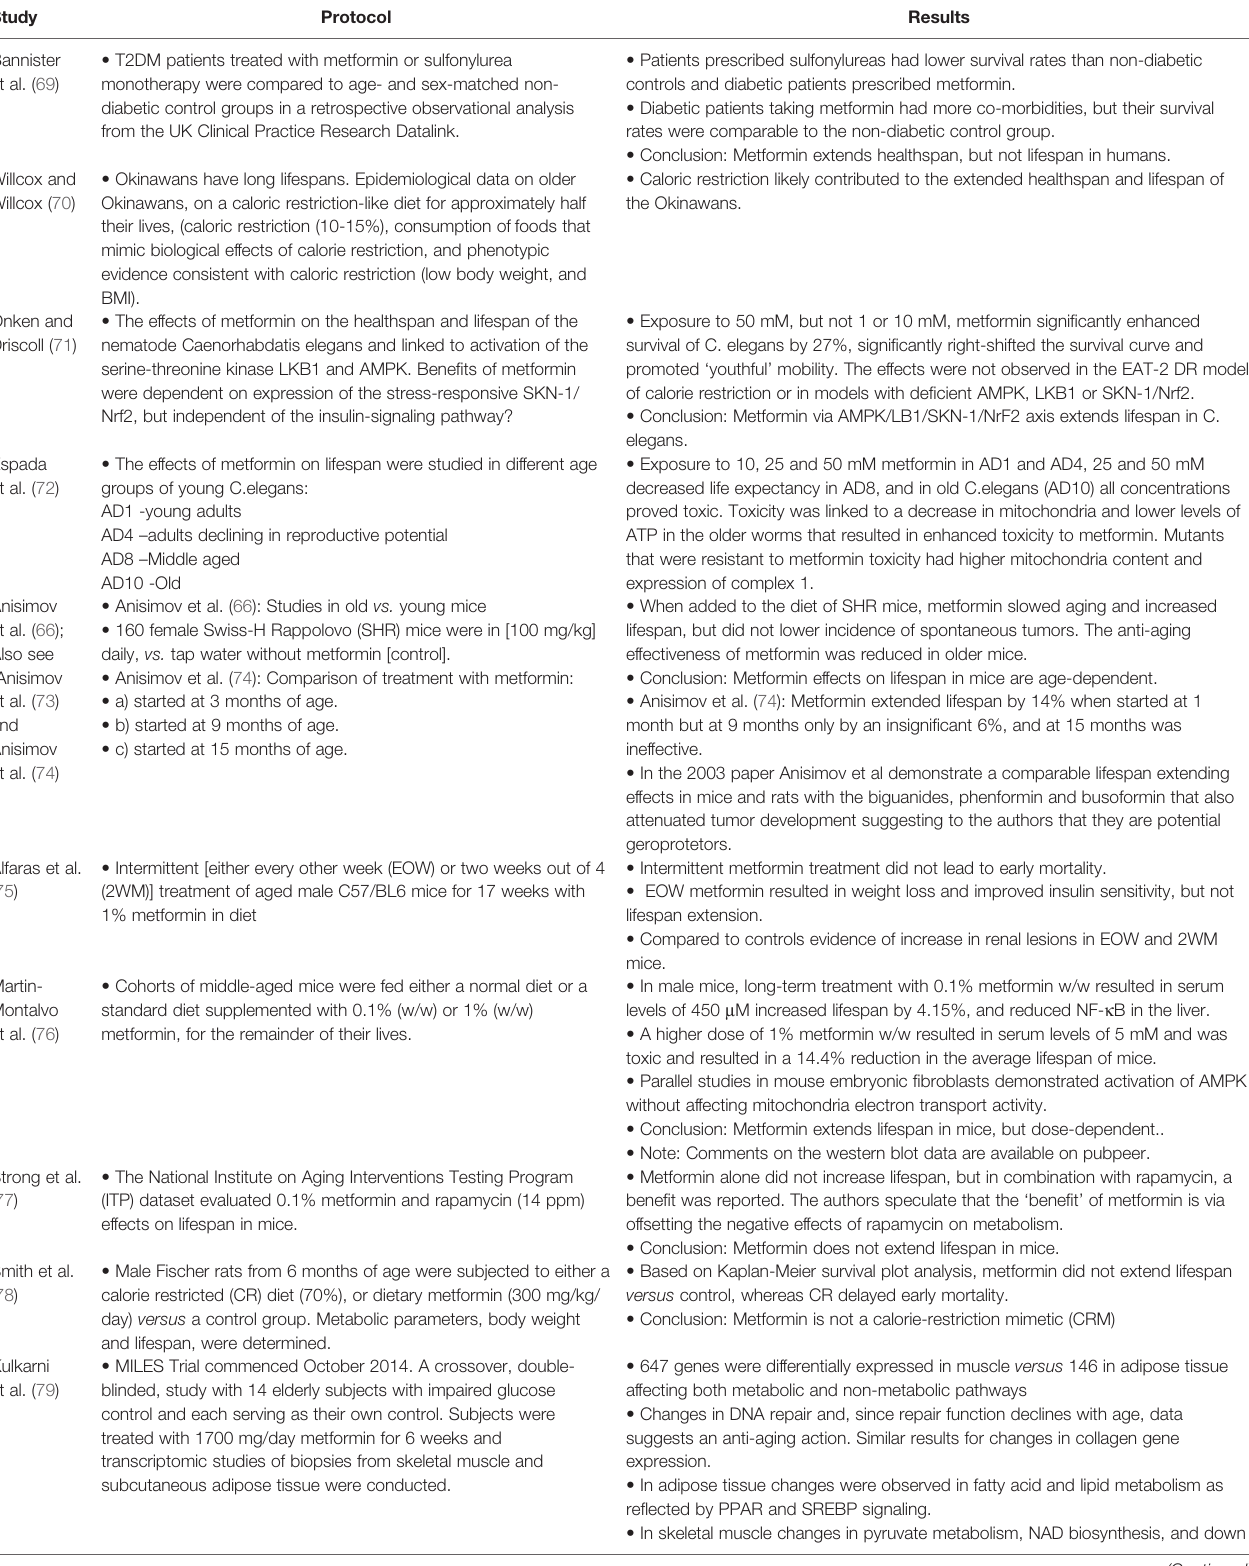
TABLE 1 | Summaries of studies cited in the review with a focus on the effects of metformin on